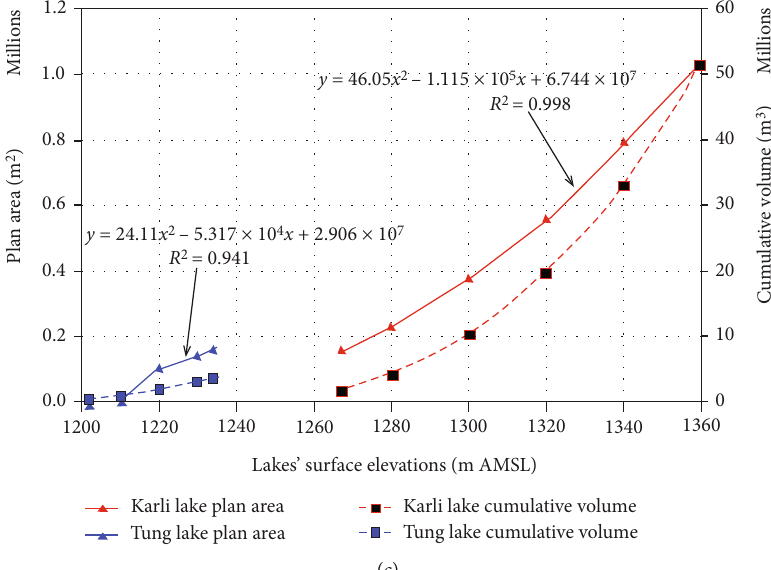
Figure 16: (a) Filling curves and lake periodic surface elevations for Karli and Tung lakes (signi fi cant events related to Karli lake are also shown): October 08, 2005, to March 31, 2007; (b) hydrological data including in fl ows of the two lakes and the downstream discharge from Hattian Bala landslide dam, daily precipitation in Hattian Bala area, and the average historical precipitation from NOAA [31]: December 26, 2005, to December 31, 2006; (c) plan area and corresponding cumulative volume vs. lake surface elevation for Karli and Tung lakes calculated from the contour maps.